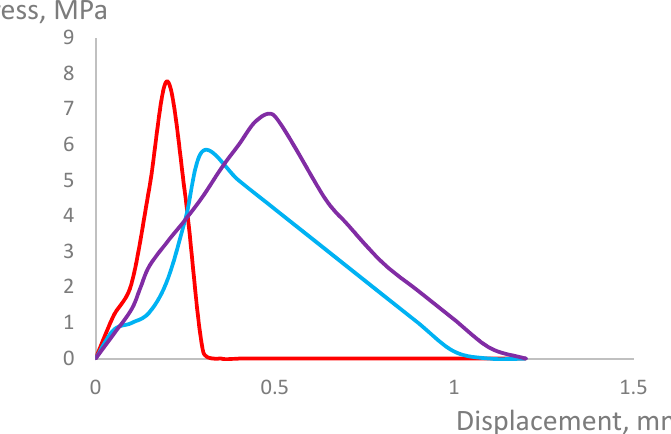
Figure 9. Deformation curves of samples during the bending stress test.